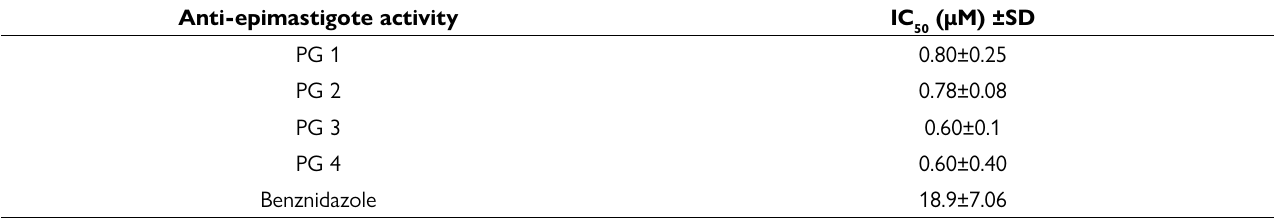
Table 3. Biological activity of natural, extracted and purified prodigiosin preparations against T. cruzi epimastigotes (CL strain, clone B5).